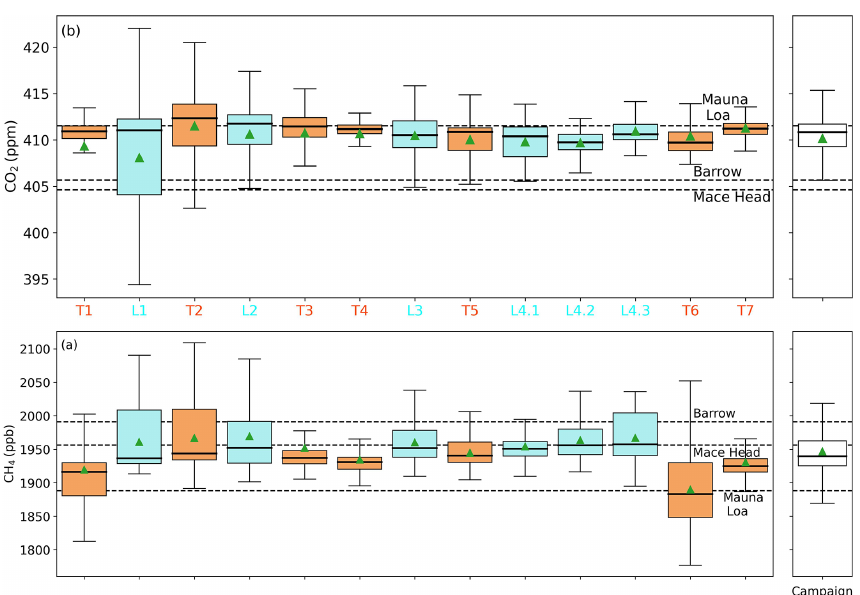
Figure 4. (a) CH 4 mixing ratio variability by flight. Statistics for the entire campaign are shown in the right panel. The boxplot shows the interquartile range (25%–75%) and the median value. The whiskers extend to the lowest and highest values, ignoring outliers beyond 1.5 times the interquartile range. Flight means are shown as green triangles. Dashed lines show respectively the mean monthly mixing ratios at Mauna Loa and Mace Head marine sector during September 2020. (b) Same as (a) for CO 2 .